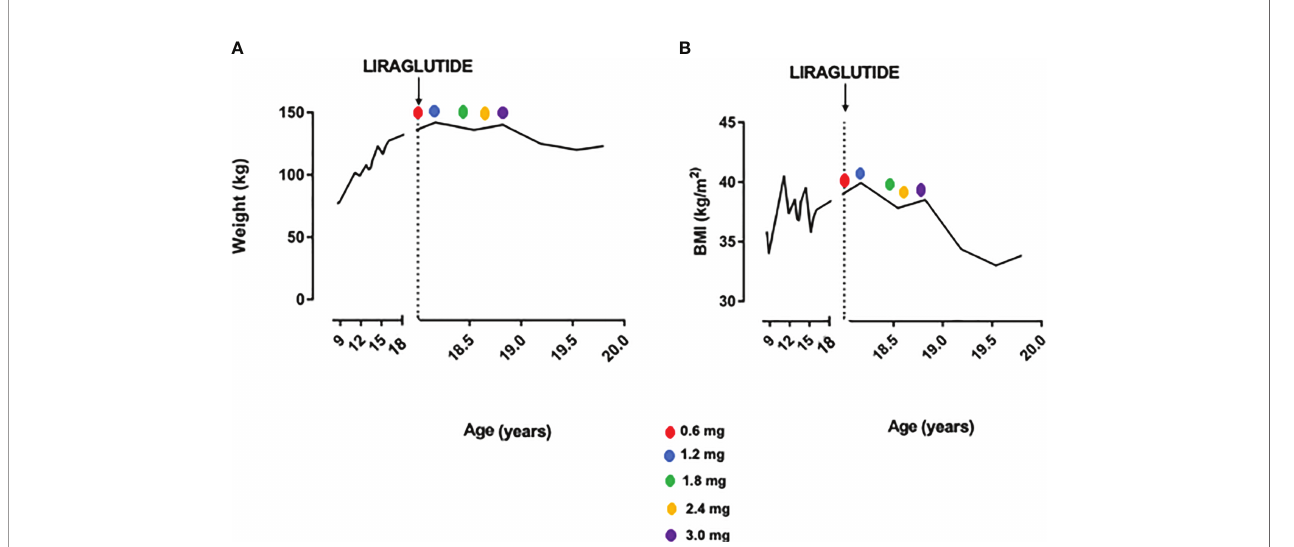
FIGURE 1 | Weight (A) and BMI (B) trend before and after liraglutide